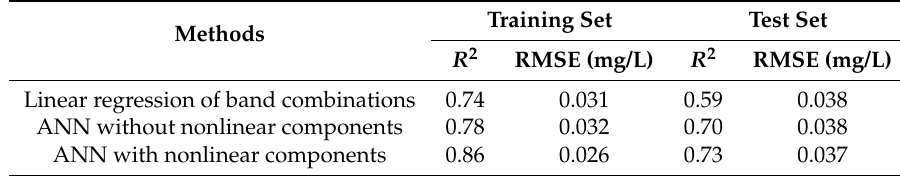
Table 1. The estimation results of the linear regression and ANN-based methods in Lake Okeechobee.